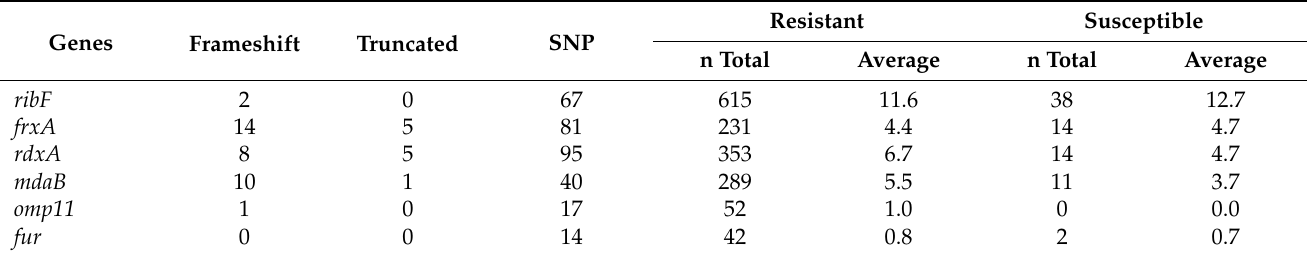
Table 3. Genetic variations associated with metronidazole resistance in H. pylori .